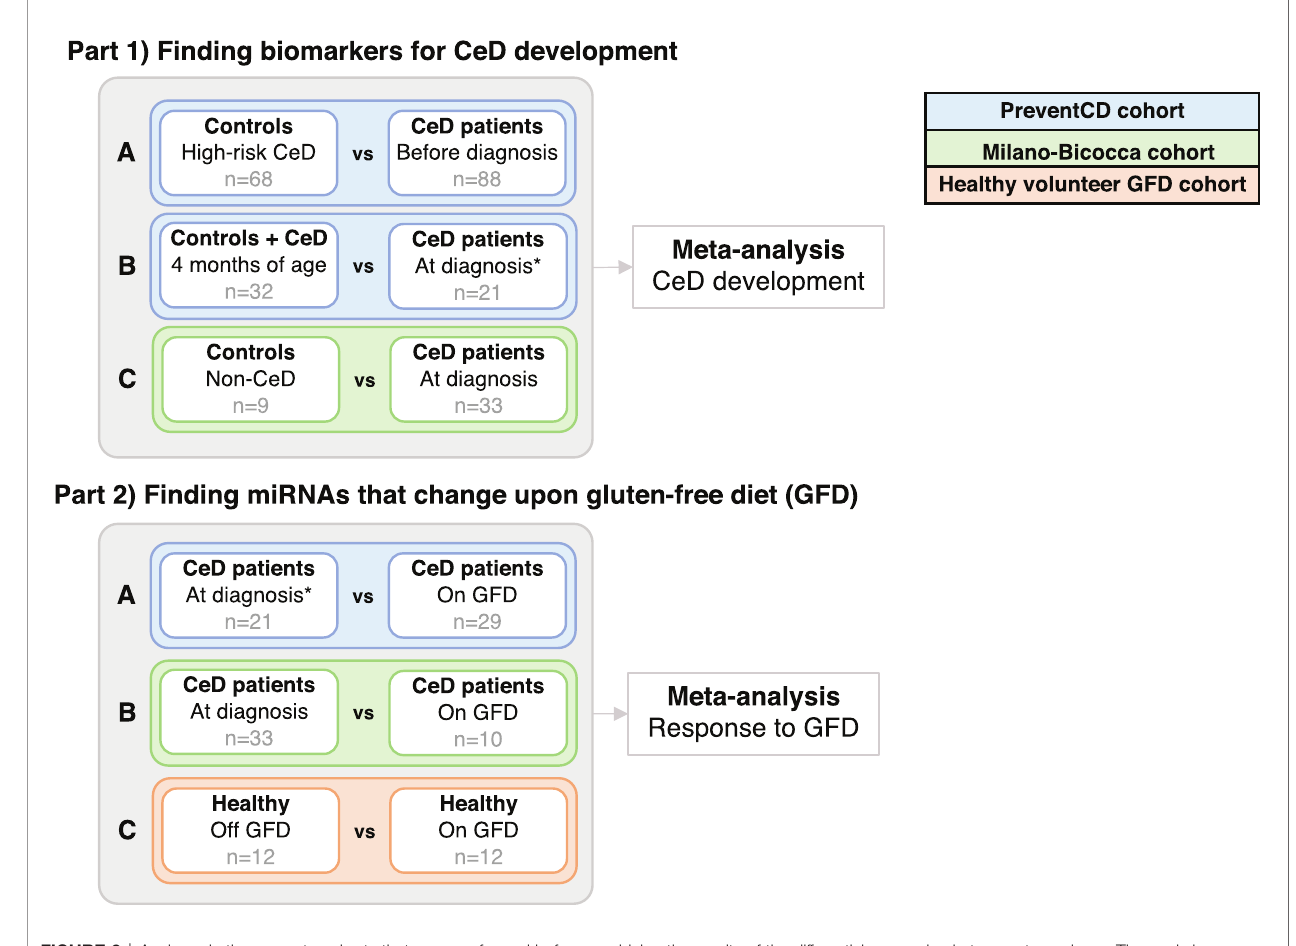
FIGURE 2 | Analyses in the separate cohorts that were performed before combining the results of the differential expression in two meta-analyses. The goals here were to: in part 1) fi nd miRNAs that are potential biomarkers for CeD development and part 2) fi nd miRNAs that change upon the gluten-free diet (GFD). Corresponding sample sizes are shown in grey. *In the PreventCD cohort, the samples “ at diagnosis ” include samples at seroconversion ( fi rst positive IgA anti-transglutaminase (TGA) levels) and samples taken close to the diagnostic biopsy. All samples in the “ before diagnosis ” groups had negative TGA